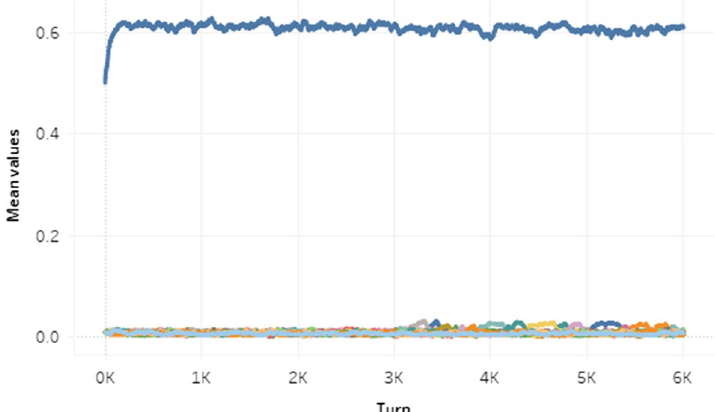
Fig. 9 Airdrop, case 2-B: Time series of the mean of view. Case 2-B is a case in which cryptocurrency can be selected as a utility (with the cryptocurrency agent) and 1 unit is distributed to a random person each turn. Blue line is the fiat money good, red line is the cryptocurrency good, and other colors represent remaining goods. In this case, the monetary function of the fiat money good remains unchanged after turn 3001 of